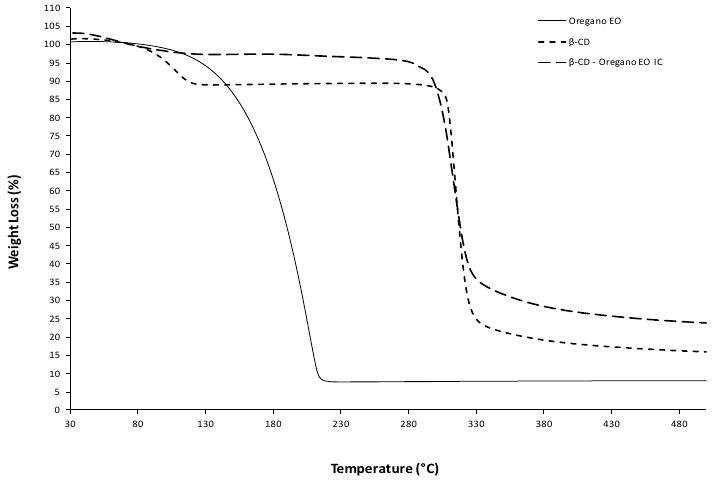
Figure 2. The TGA graphs of the oregano EO, β -CD and β -CD—oregano EO ICs.